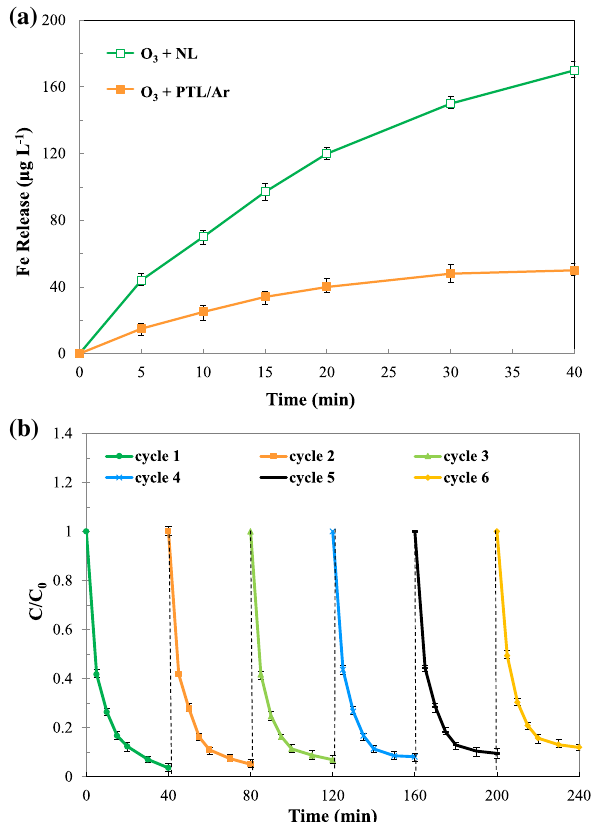
Figure 11. ( a ) Fe release in the O 3 + NL and O 3 + PTL/Ar processes ( b ) PhP degradation over 6 cycles in the